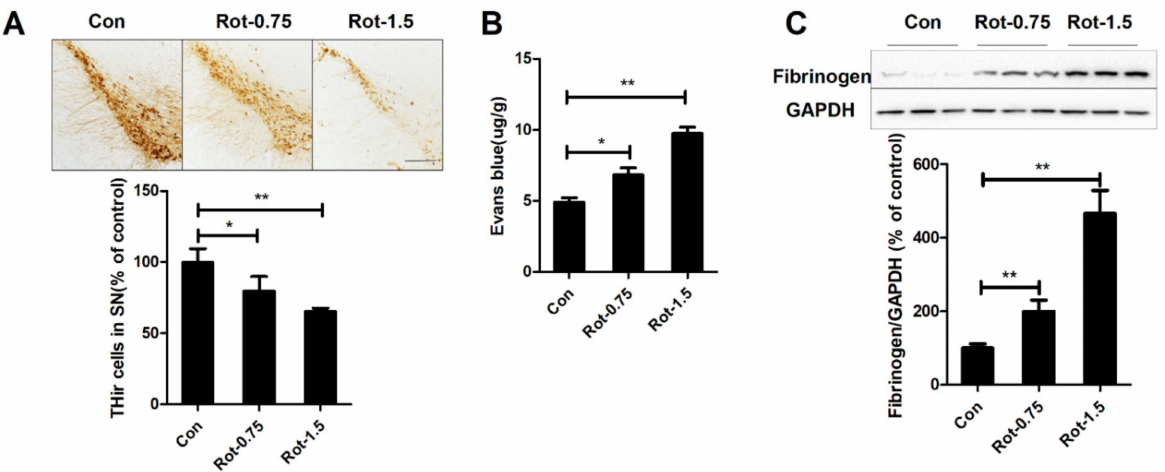
Figure 1. Rotenone dose-dependently damages dopaminergic neurons and elevates BBB permeabil- ity in mice. ( A ) Representative images of dopaminergic neuron staining and the number of TH+ dopaminergic neurons in the SNpc of mice for each group. ( B ) The contents of Evans blue in the midbrain of mice were determined. n = 3. ( C ) Representative blots of fibrinogen in the midbrain of mice and the quantification of fibrinogen blots. n = 6. * p < 0.05, ** p < 0.01; scale bar = 100 µ m. Con: vehicle-treated mice group; Rot-0.75: 0.75 mg/kg/d rotenone-treated mice group; Rot-1.5: 1.5 mg/kg/d rotenone-treated mice